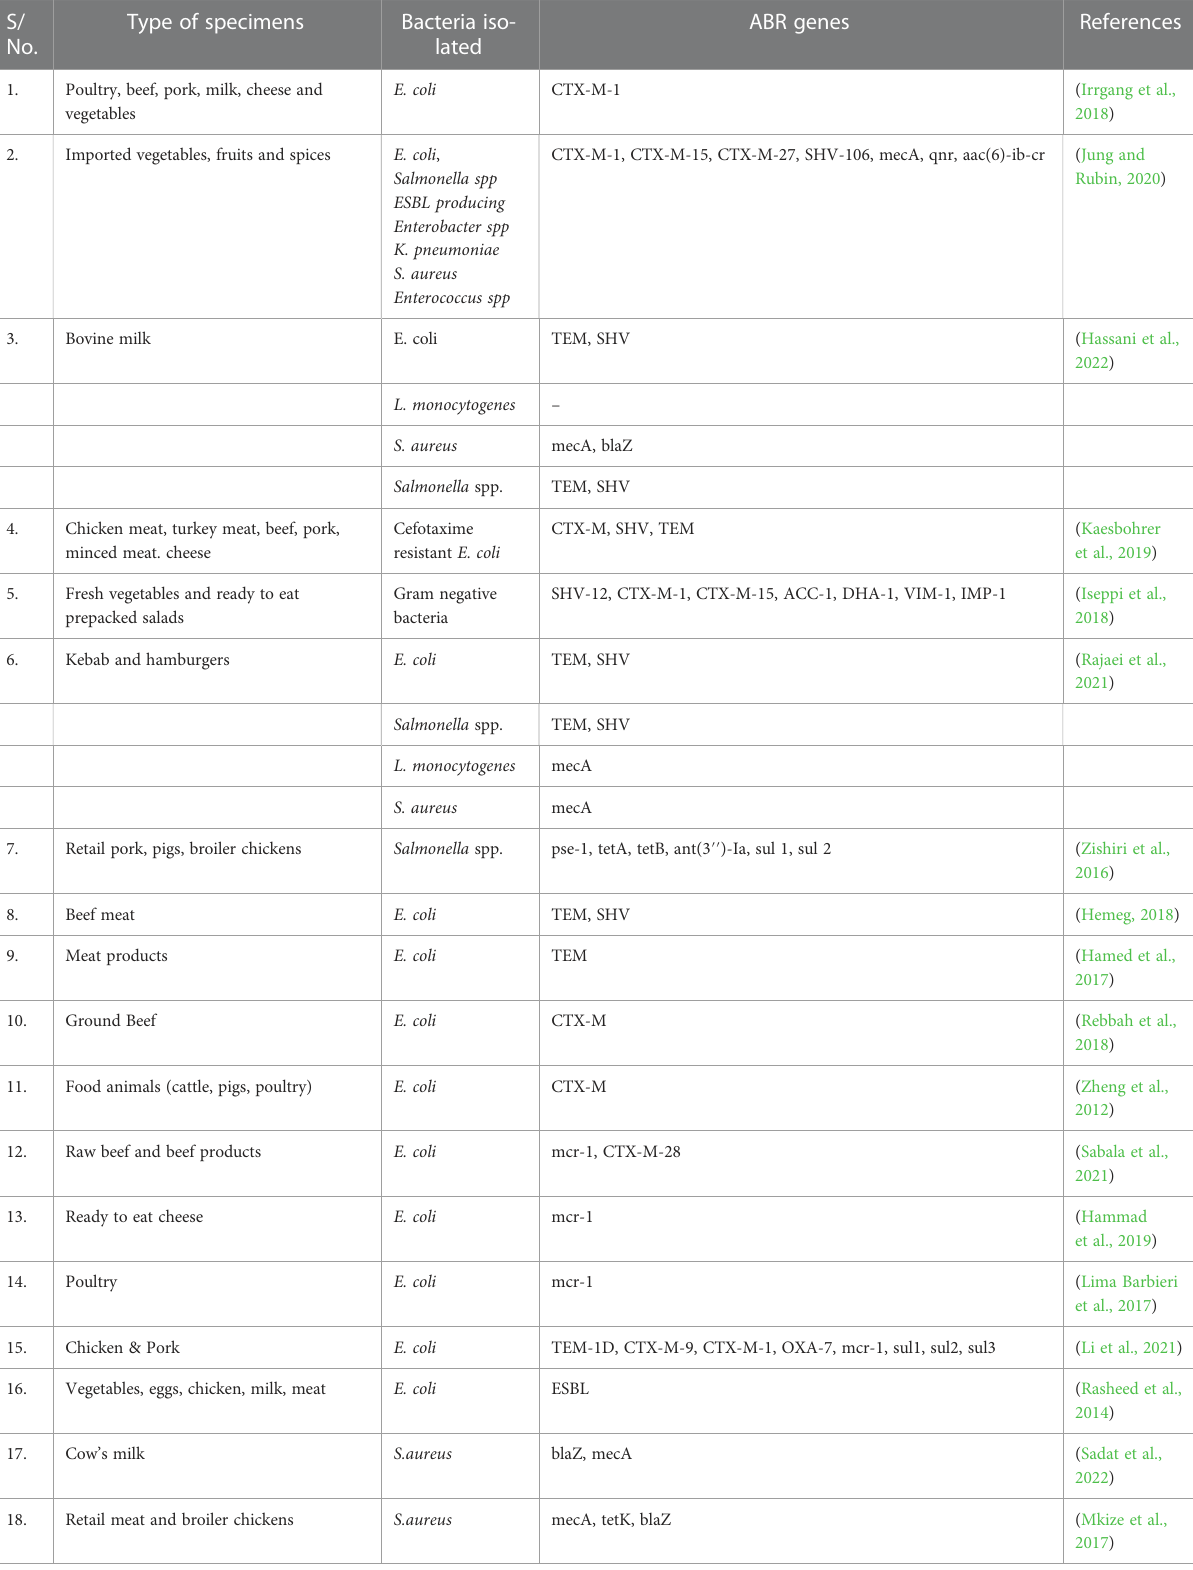
TABLE 3 Some studies reporting the distribution of ABR genes among the bacterial isolates from food producing animals, and food